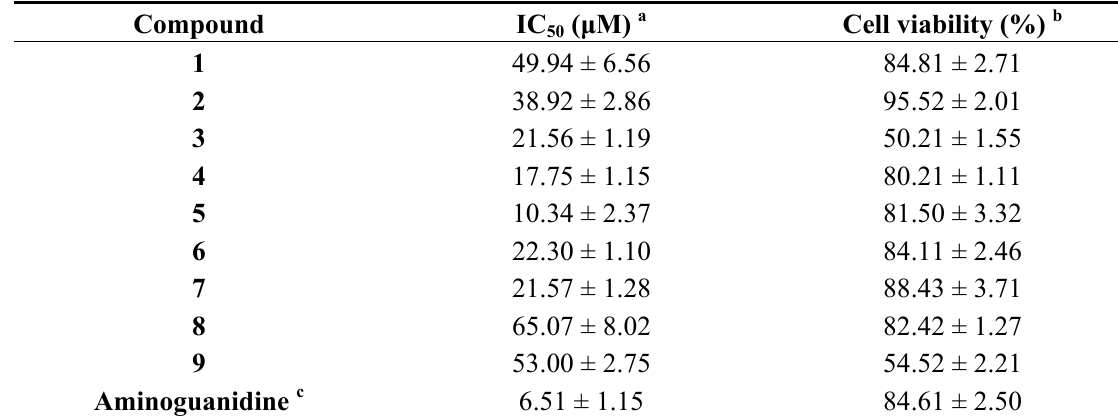
Table 2. Inhibitory effects of compounds 1  9 against LPS-Induced NO production in RAW 264.7 macrophage